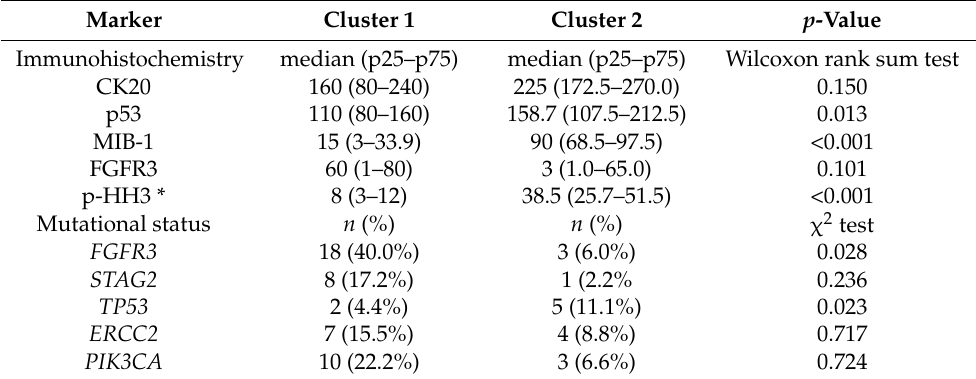
Table 4. Comparison of protein and mutational status among the